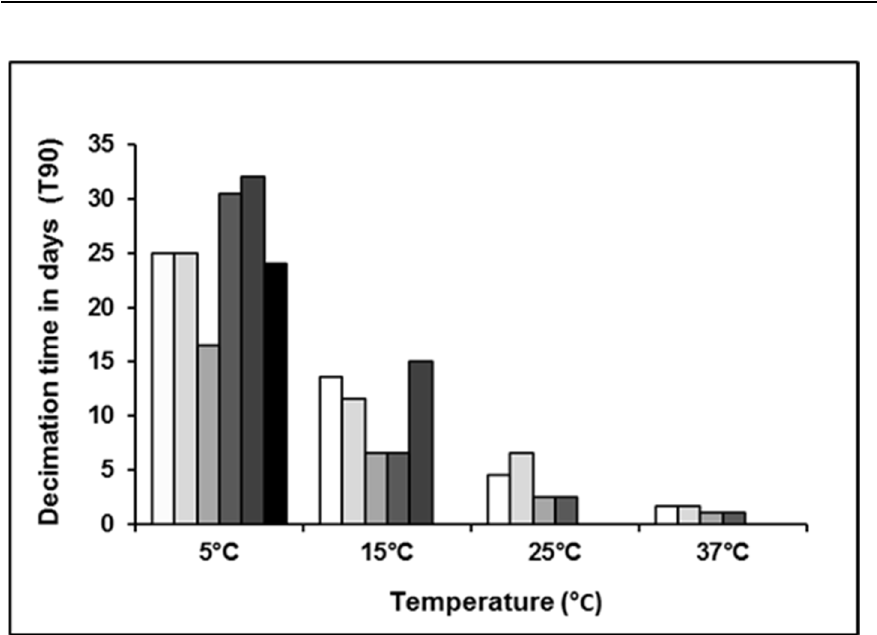
In addition to temperature, the initial load of LA-MRSA also influenced the decima- tion time, with the high spiking dose having a longer decimation time than the low spik- ing dose (Figure 1). White = t011 low load, light gray = t034 low load, gray = t011 high load, semidark gray = t034 high load, dark gray = natural sample 100 CFU/mL, black = natural sample = 20 CFU/mL.